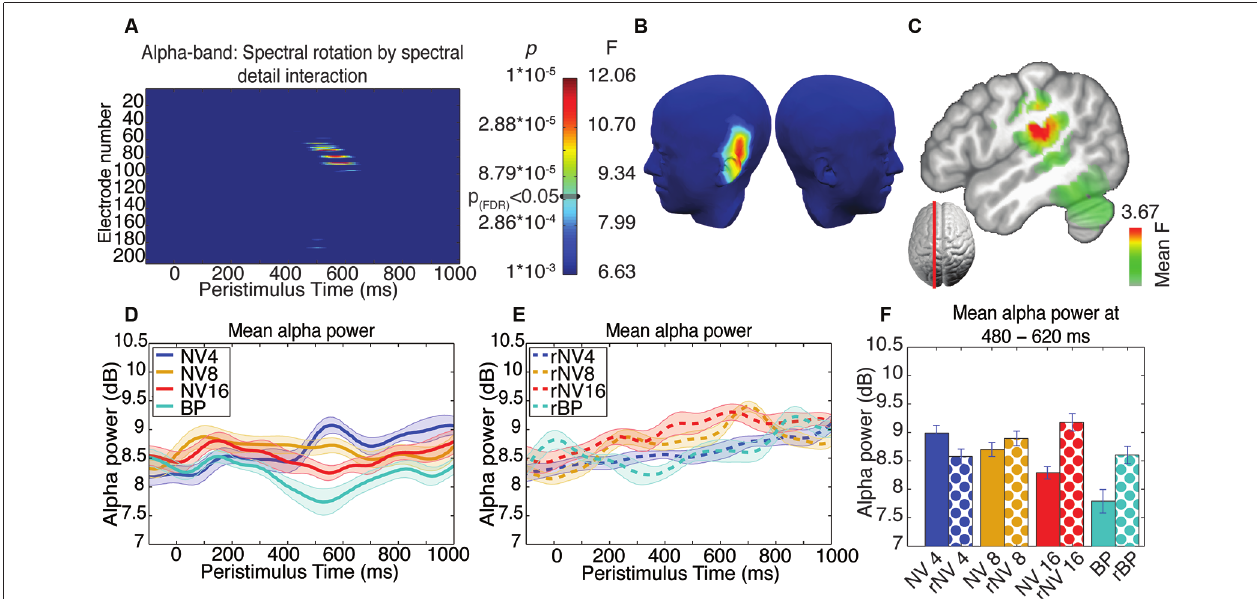
temporal structures, showing the average F -statistic over the time-window of interest. (D) Average time-course of this effect in a cluster of five contributing electrodes across NV conditions, demonstrating enhanced alpha-band suppression for more intelligible conditions. (E) Corresponding time-courses for the spectrally rotated conditions, where the effect of spectral detail is absent. (F) Alpha-band activity for each condition in the significant time-window, error bars represent standard error of the mean corrected to be appropriate for repeated-measures comparisons, as described in Loftus and Masson